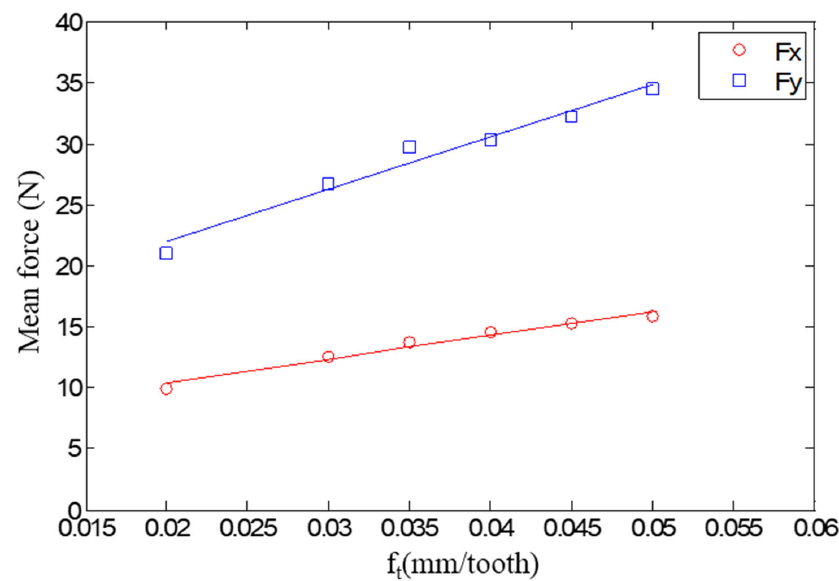
Table 2. Specific cutting force coefficients.